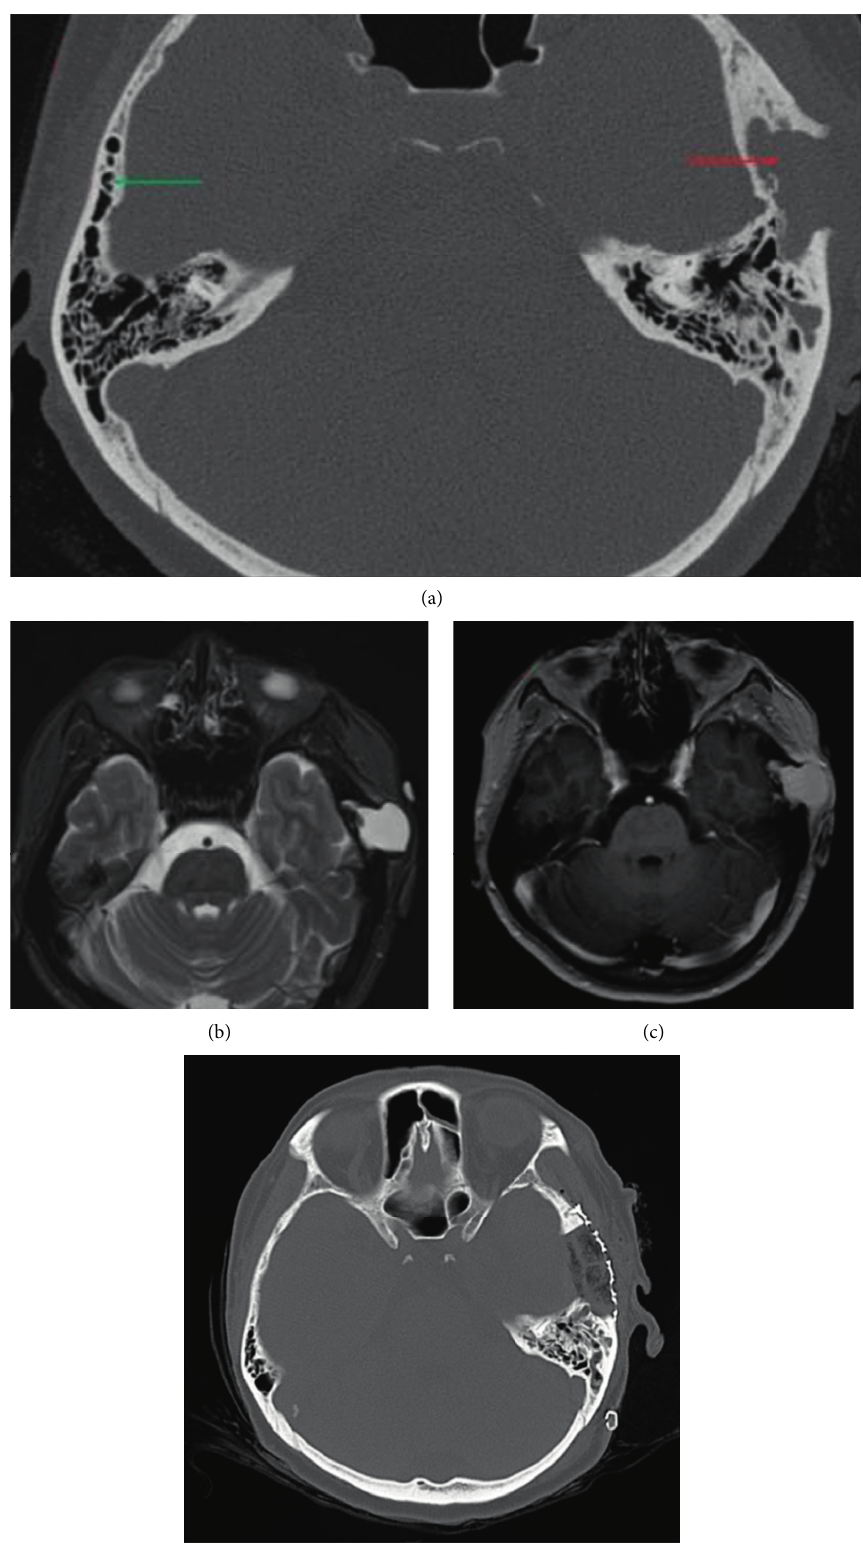
Figure 1: (a) Axial CTof the temporal bones showing a cystic mass of the left squamosal temporal bone disrupting the lateral cortex on the left (red arrow) and a well-pneumatized contralateral squamosal bone (green arrow). (b) T2-weighted axial MRI showing a fluid-filled mass at the left squamosal temporal bone. (c) T1 imaging reveals the lesion to be hyperintense and nonenhancing. (d) Postoperative CTshowing complete resection with reconstruction via mesh